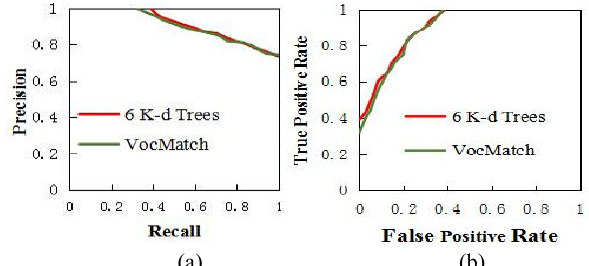
Figure 9. (a) Precision-recall and (b) ROC curve of different size random k-d forest.